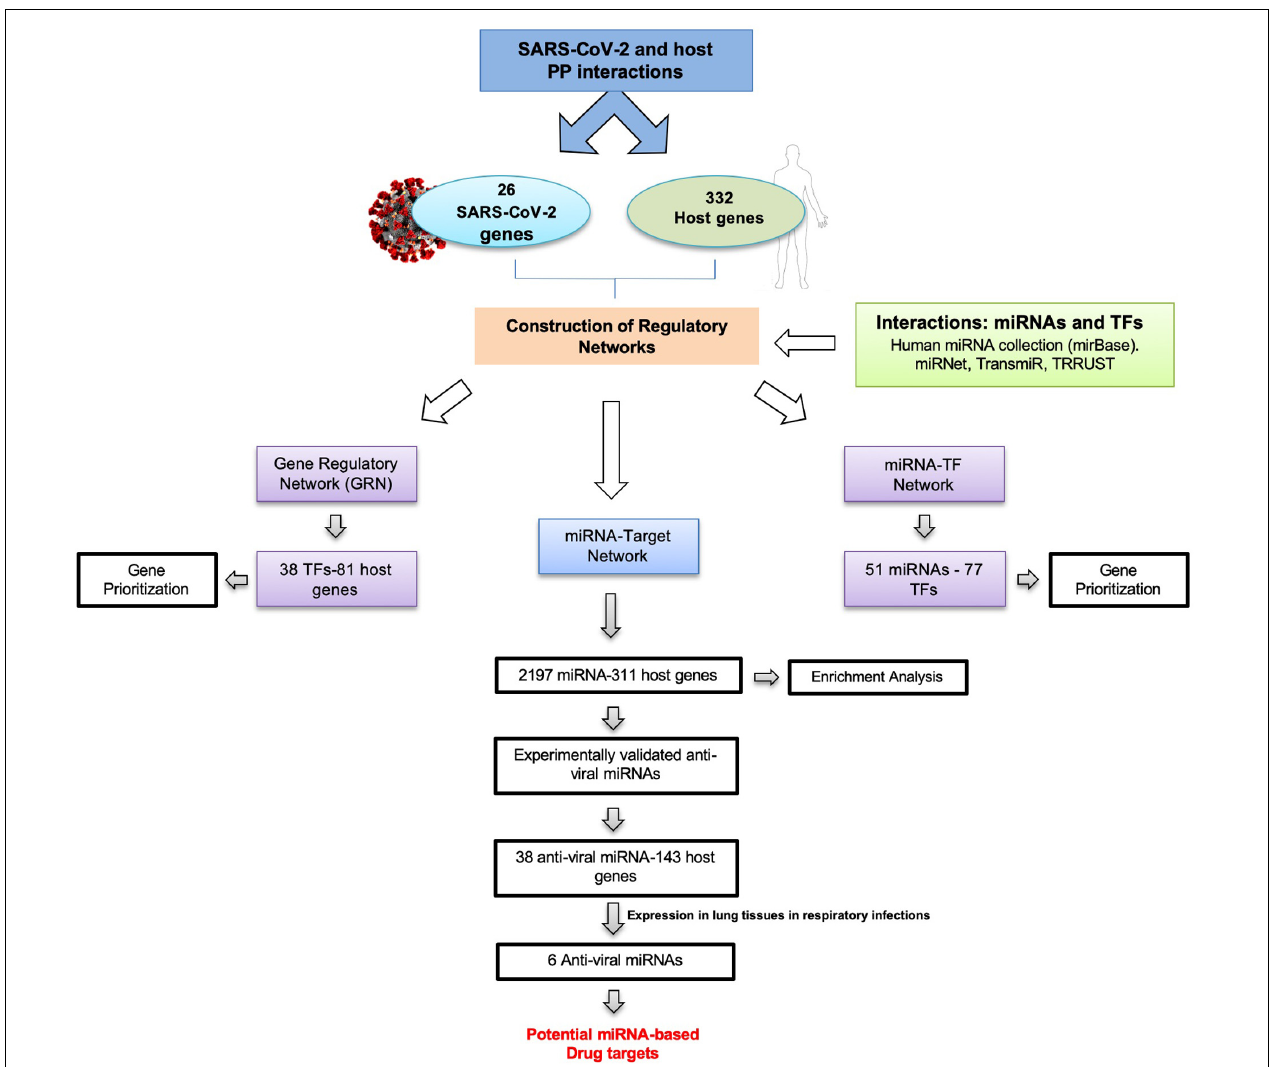
FIGURE 2 | Pipeline design to identify novel drug targets in SARS-CoV-2 by generation and analysis of gene regulatory